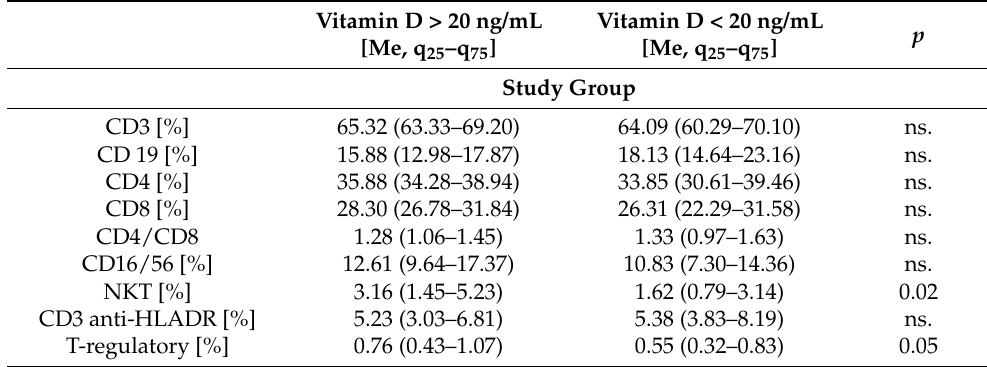
Table 3. Effect of vitamin D on the phenotype of peripheral blood